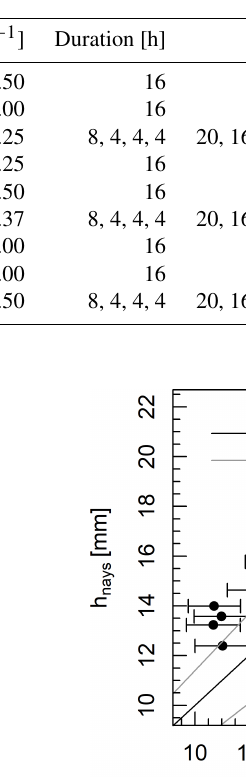
Table 2. Summary of experiments conducted in the A-BES. The DEM count excludes screeded bed. Experiment 1 is published in Adams and Zampiron (2020).